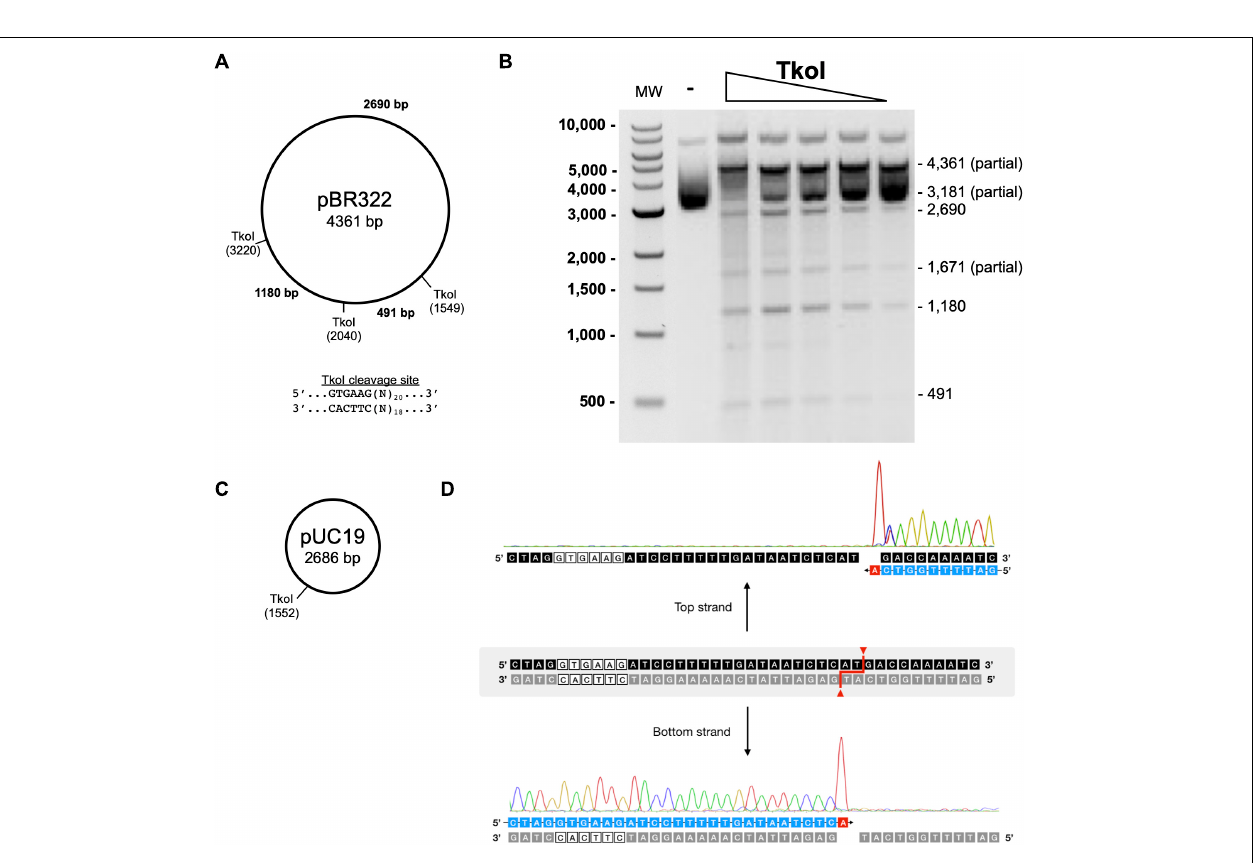
FIGURE 5 | Characterization of TkoI restriction endonuclease activities. (A) Predicted TkoI recognition sites in plasmid pBR322 are at positions 1,549, 2,040, and 3,220. (B) TkoI was incubated with pBR322 in 1X NEBuffer 3 supplemented with SAM and 90mer trans-DNA for 30 min at 65 ◦ C. Reactions were halted with Proteinase K and loading dye and separated on a 1% agarose gel. Lane 1 is a 1 kb DNA ladder. Lane 2 is pBR322 alone and lanes 3–7 are decreasing amounts of TkoI (400–25 nM). (C) TkoI cleaves pUC19 at a single site. (D) pUC19/TkoI cut fragments were analyzed by run off sequencing to determine TkoI cut sites on the top and bottom strands: GTGAAG(N) 20 /(N) 18